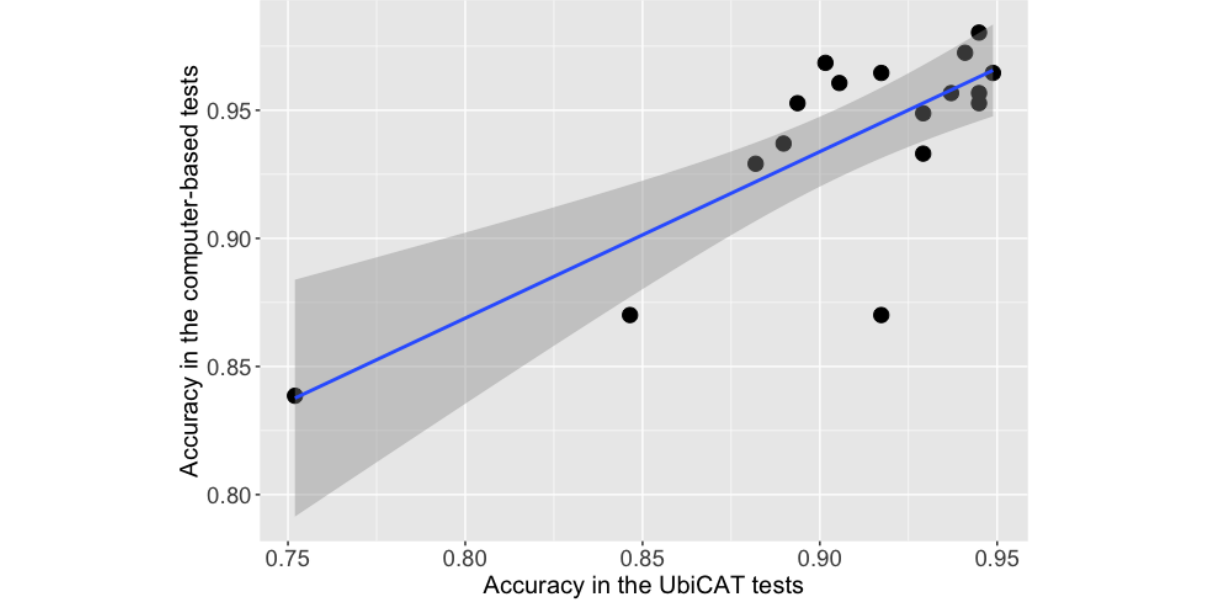
Figure 5. Overall participant accuracy in the three cognitive tests. Each black dot represents results from one participant. The blue line is the regression line and the shaded region is the CI. UbiCAT: Ubiquitous Cognitive Assessment Tool.